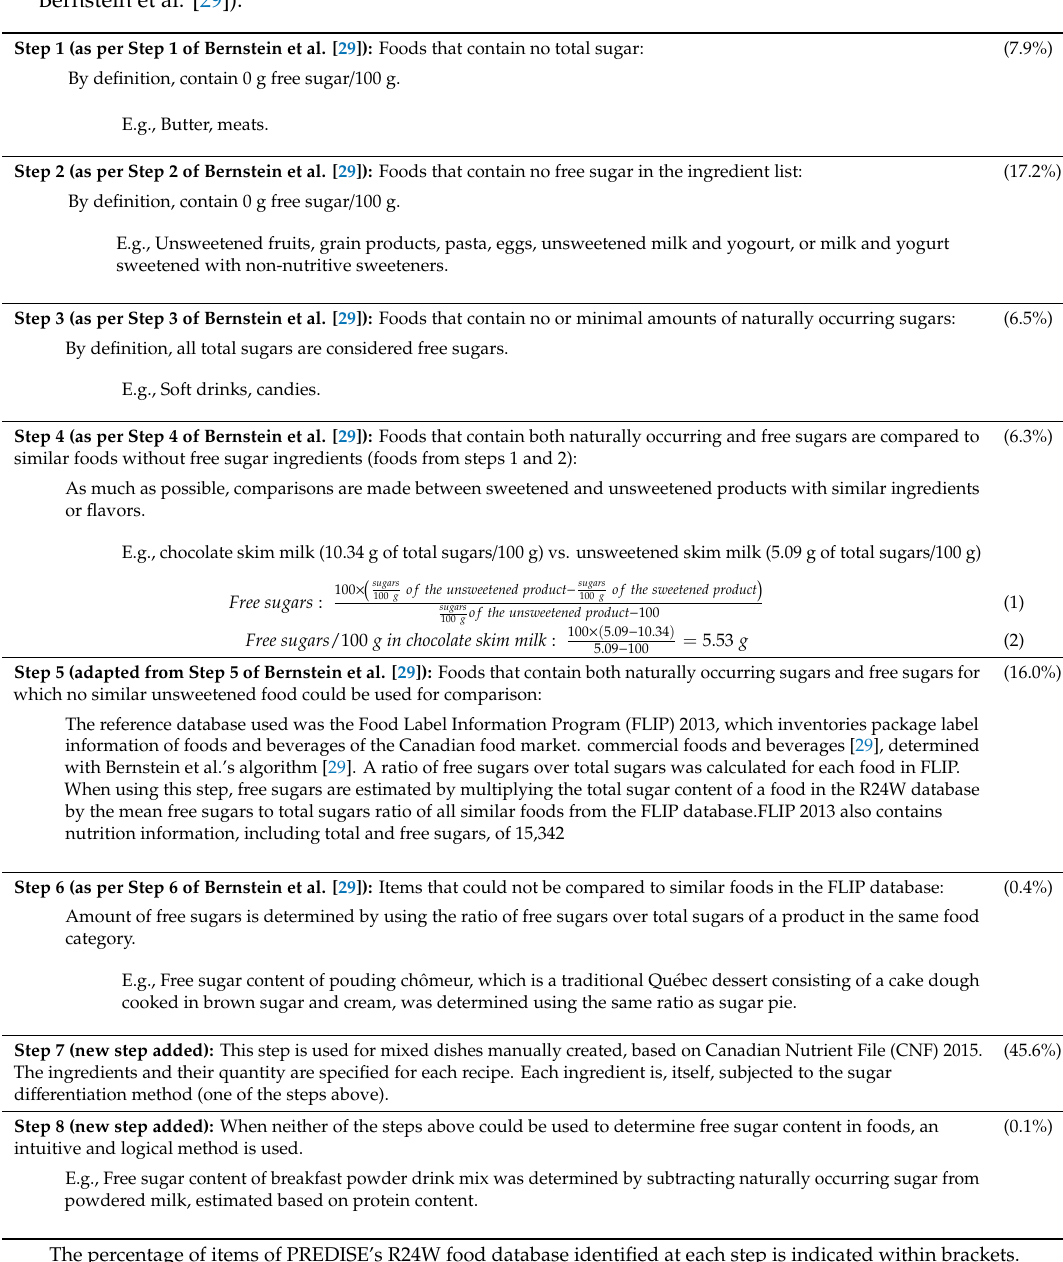
Table 1. Method for calculating the content of free sugars in foods and recipes (adapted from Bernstein et al.